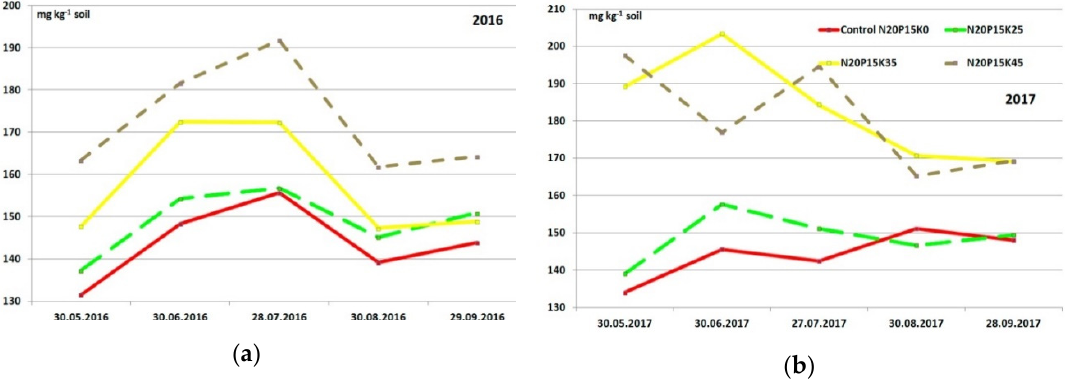
Figure 1. Seasonal changes of the soil exchangeable potassium content, cv. “Zhigulevskoye” plots: ( a ) 2016 and ( b ) 2017 (only G1 unchangeable K rates).